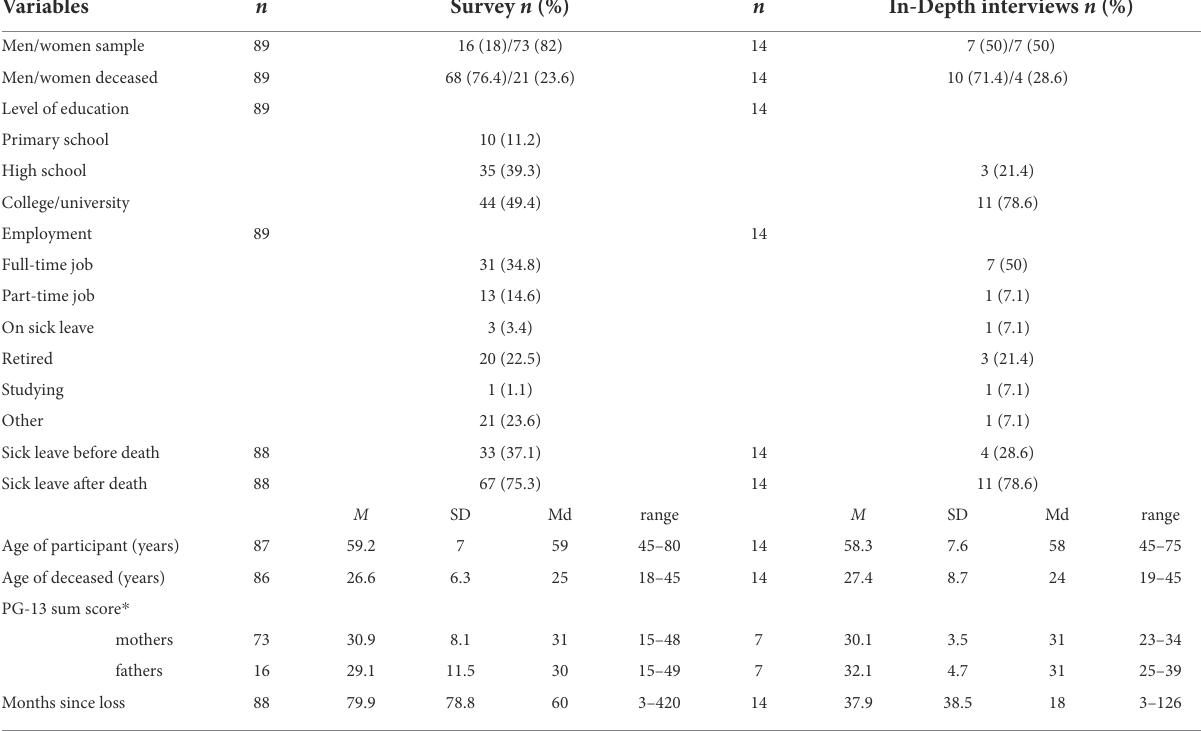
TABLE 1 Demographic and loss-related variables for the survey and the in-depth interview sample.